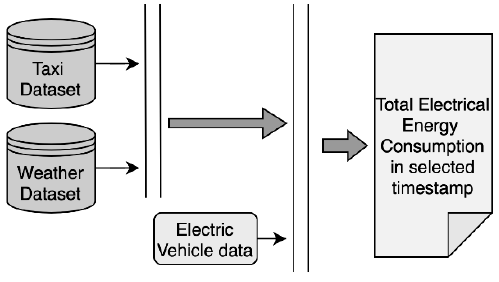
Figure 3. The datasets’ schema.